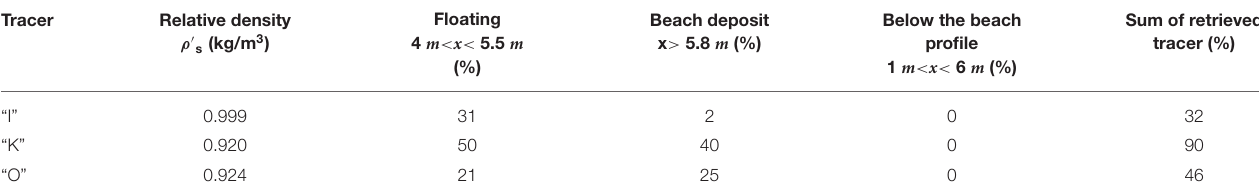
TABLE 3 | Distribution of floating MPs after